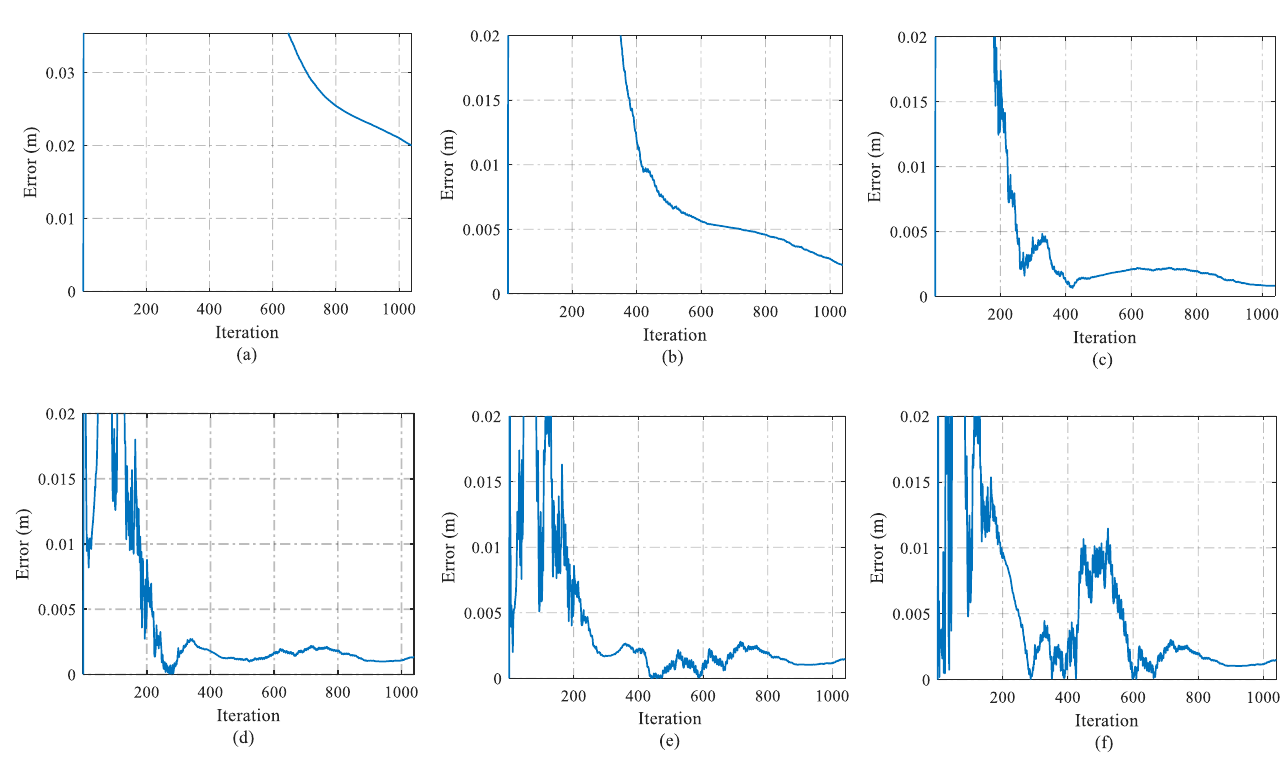
Figure 5. The error of filtering results versus different observation noise covariance W. ( a ) W = 10 − 2 . ( b ) W = 10 − 3 . ( c ) W = 10 − 4 . ( d ) W = 10 − 5 . ( e ) W = 10 − 6 . ( f ) W = 10 − 7